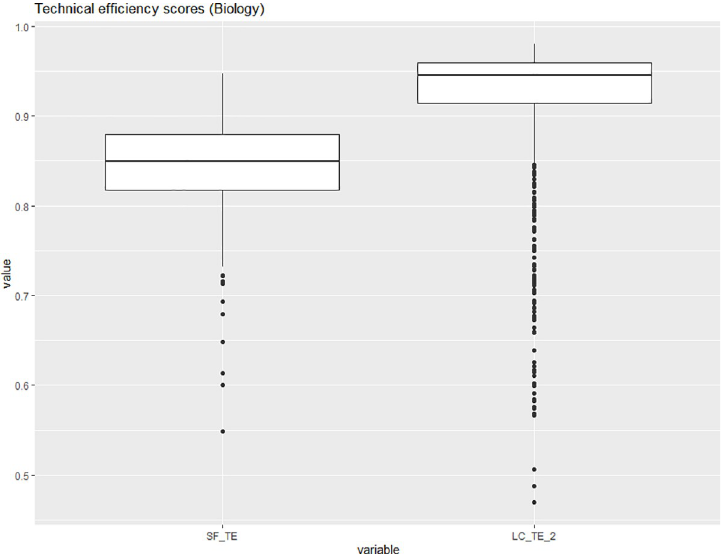
https://doi.org/10.1371/journal.pone.0247437.g007